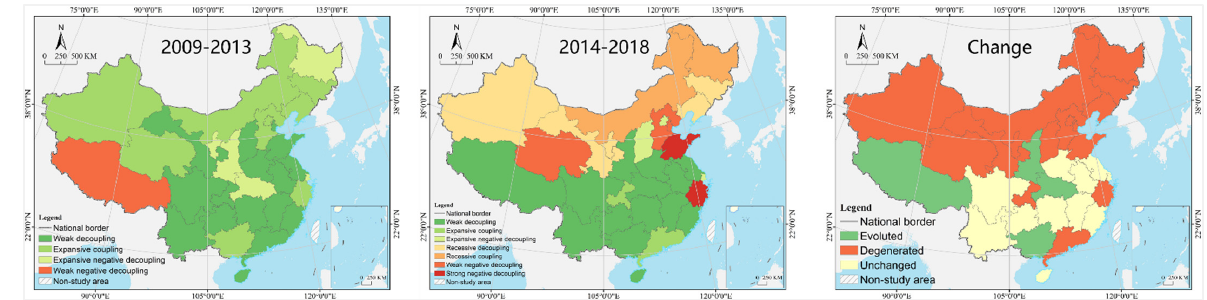
Figure 8. Analysis on the eight types of decoupling relationships in total profit.